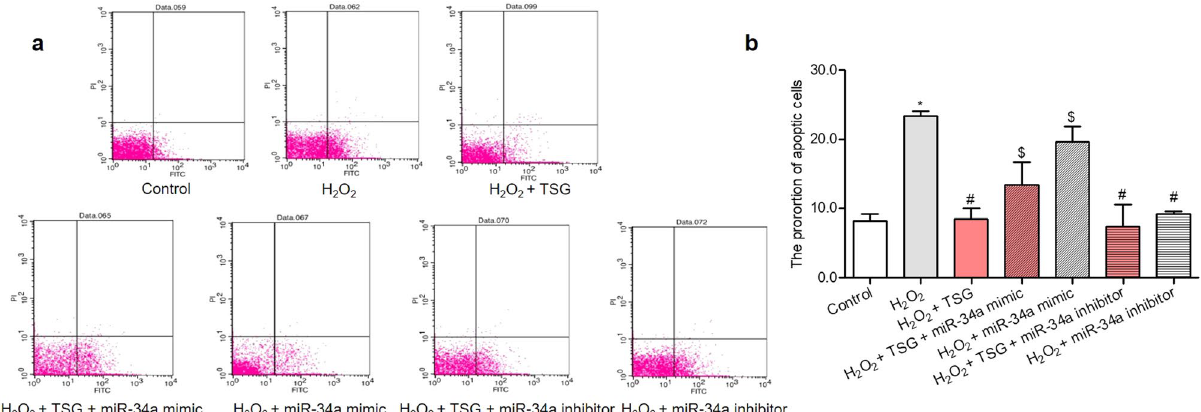
Figure 4. The effect of miR-34a over-expression or suppression on apoptosis rate of TSG on HUVECs induced by H 2 O 2 . HUVECs were transfected with miR-34a mimic or miR-34a inhibitor for 24 h, then treated with TSG for 24 h, and each group was finally induced by H 2 O 2 , except control group. The cells samples were analyzed by Fluorescein-conjugated Annexin V (Annexin V-FITC) vs propidium iodide (PI) staining, apoptotic cells were determined as Annexin V-FITC positive and PI negative. The cells located in the lower right quadrant were early apoptosis cells. ( a ) Representative flow plot of early apoptosis distribution. ( b ) The data were normalized to control. * p < 0.05 vs. control, # p < 0.05 vs. H 2 O 2 group, $ p < 0.05 vs. H 2 O 2 + TSG group.